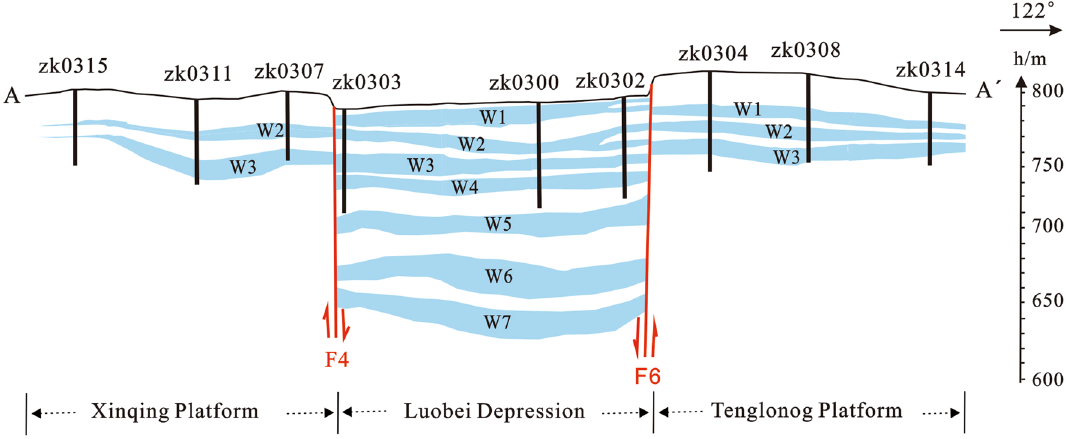
Figure 2. Cross-section of the potassium-rich brine deposit in Lop Nor